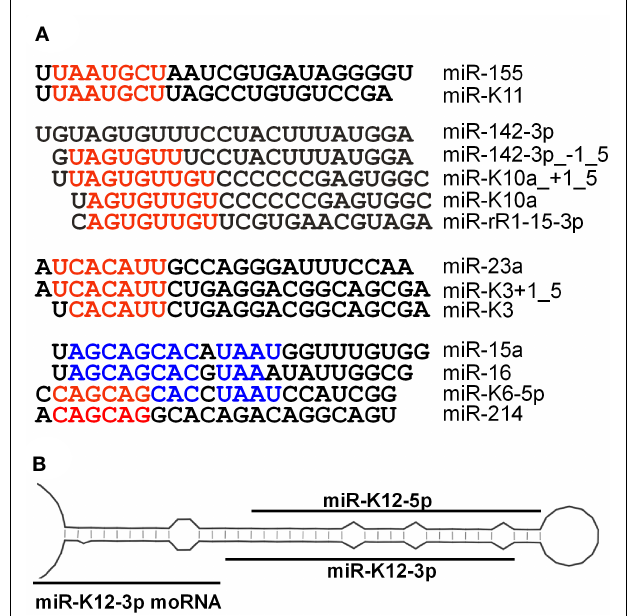
FIGURE 3 | (A) KSHV miRNAs with known or potential cellular analogs. miRNAs are aligned to show seed (red) and non-seed (blue) homologies. (B) Schematic illustrating the origin of